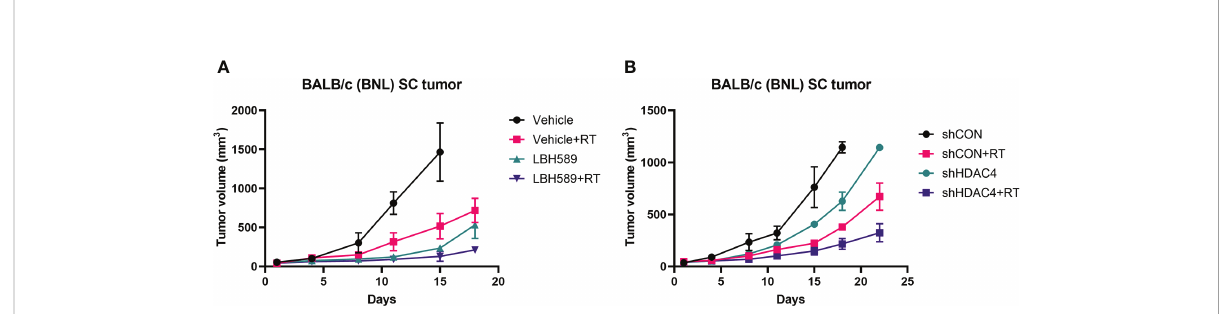
FIGURE 4 Effect of HDAC inhibition and radiotherapy (RT) on murine allograft tumor control using BNL cells. (A) Subcutaneous (SC) allografts were treated with RT and/or a pan-HDAC inhibitor, LBH589. (B) Allografts with vector-control shRNA (shCON) and HDAC4 shRNA knockdown (shHDAC4) BNL cells were treated with or without RT. Combination of HDAC inhibition and RT more effectively delayed the tumor growth than either